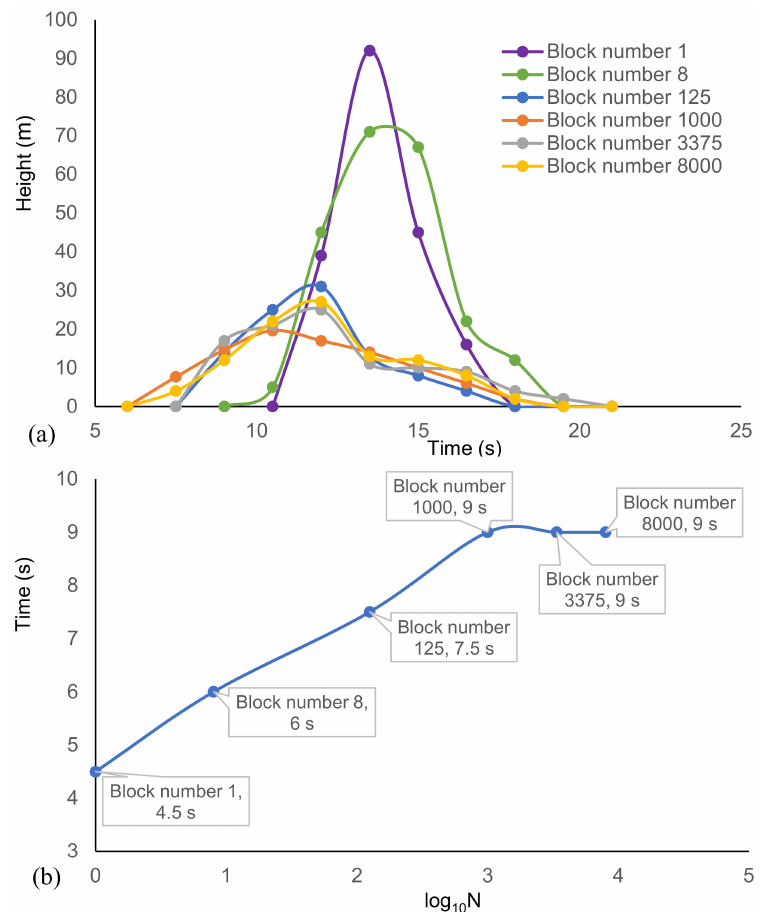
Figure 16. The characteristics of impulse waves under different fracturing conditions. N represents the potential number of blocks in the model, and: ( a ) the maximum height over time; ( b ) impulse waves propagation time to the boundary of the